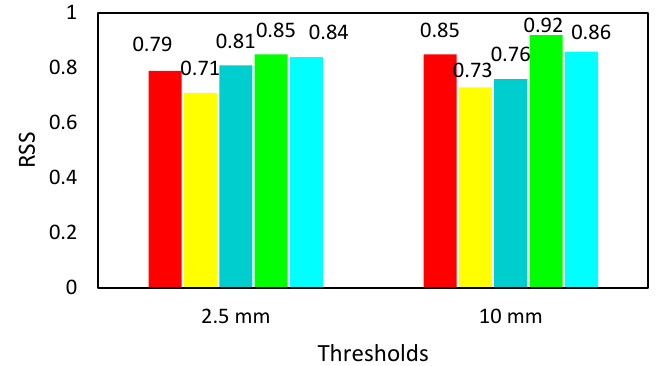
pecially in the case of the WA-WLSR model, closely match that of the observed precipita- tion.